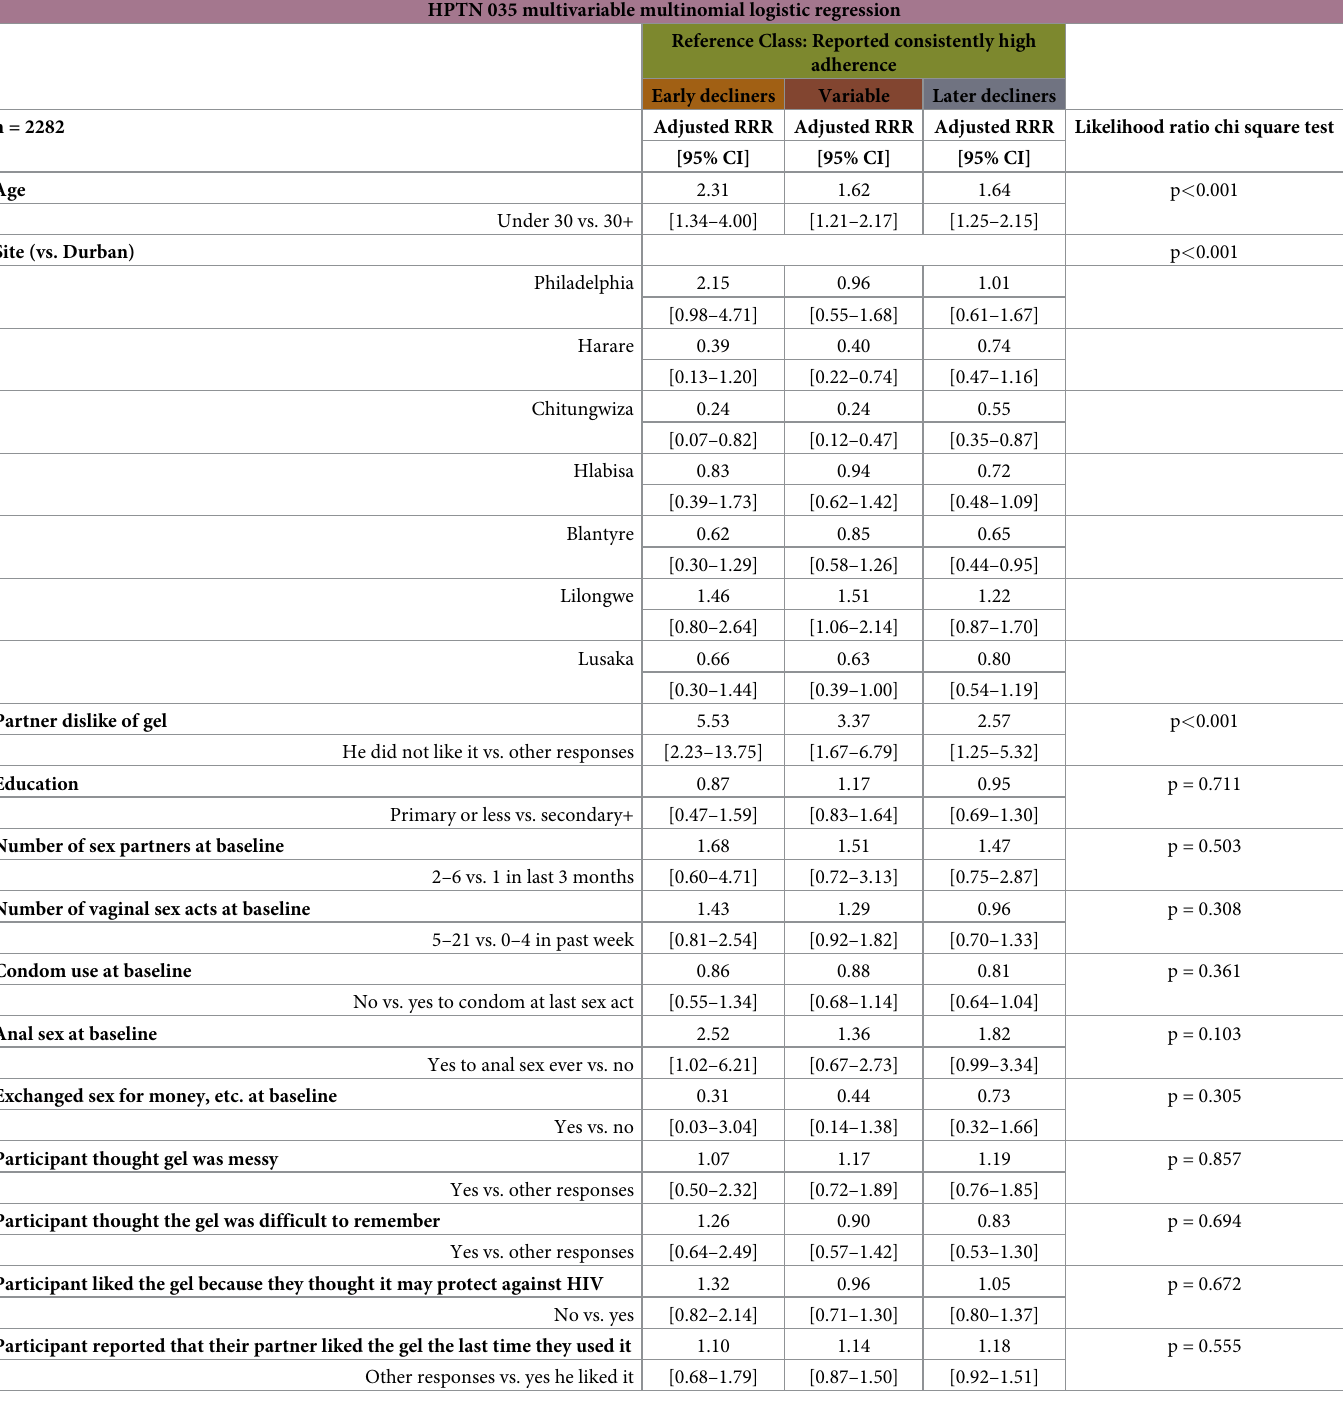
Table 2. HPTN 035 multivariable multinomial logistic